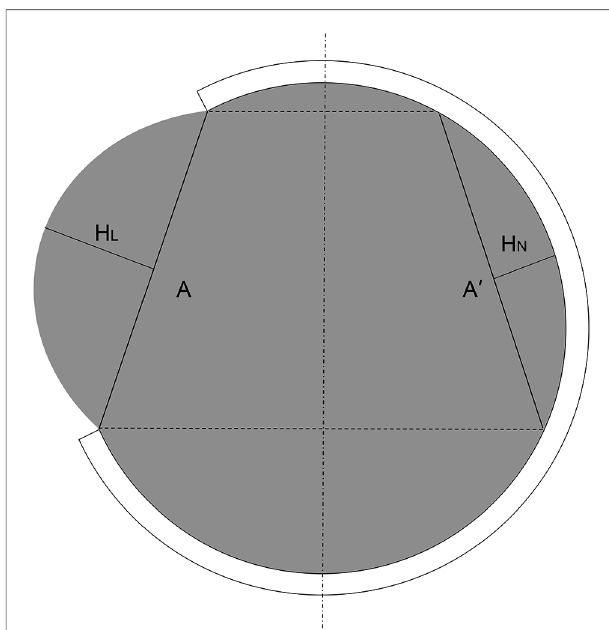
FIGURE 2 | Measurement of herniation volume on maximal hernial layer of CT (A: diameter of craniectomy; H L : maximum perpendicular distance from hernial brain tissue to line A on lesion side. H N : maximum perpendicular distance from normal brain tissue to symmetrical line A ’ on non-lesion